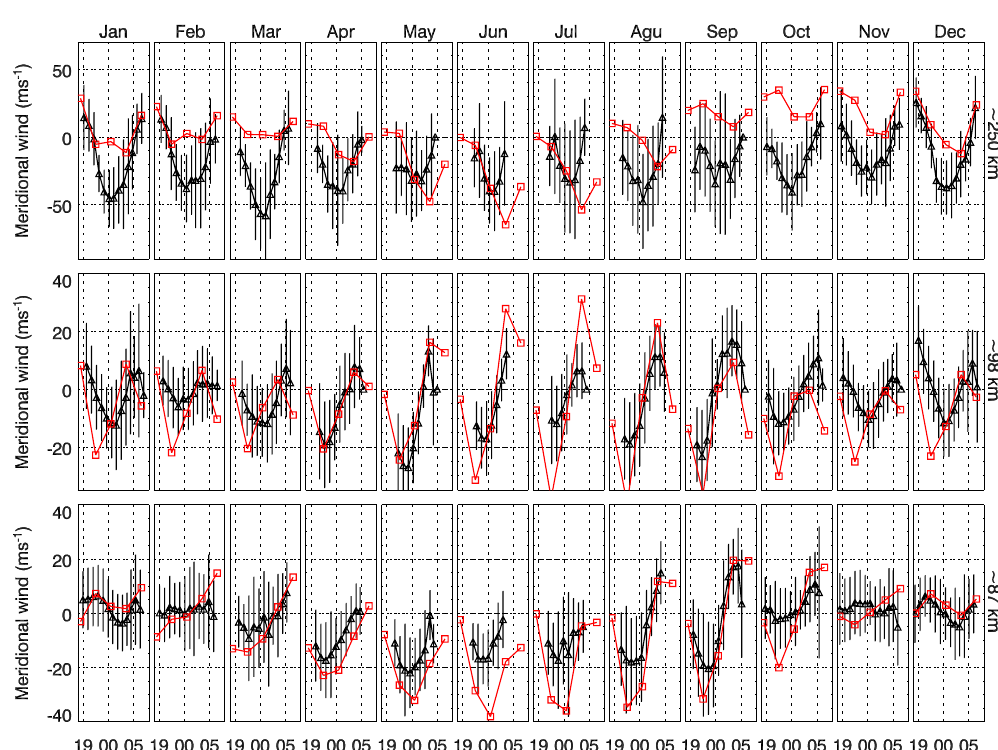
Fig. 9. Same as Fig. 7 but for the meridional (northward positive)